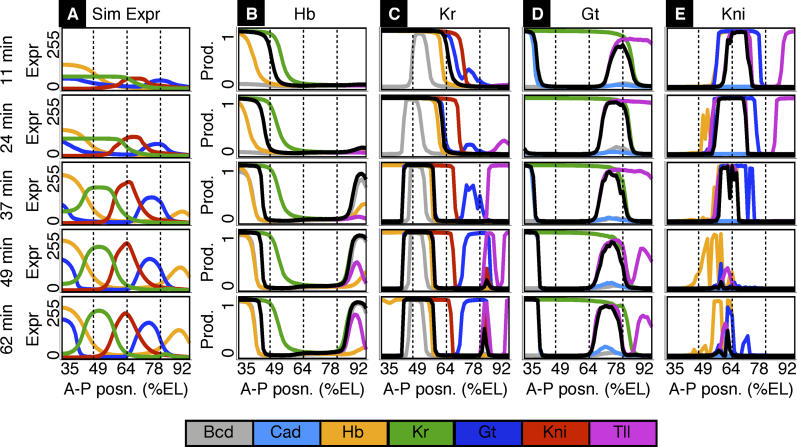
Simulated Gap Gene Expression, Production, and Regulatory Effects in the RPJ-GC Model